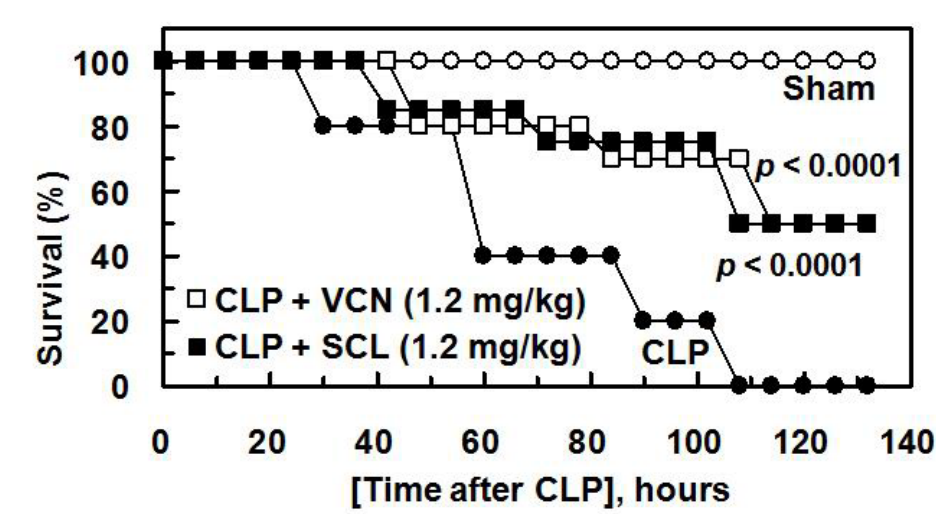
FIGURE 2 - Effects of VCN and SCL on CLP-induced septic lethality. Male C57BL/6 mice (n = 20) were administered VCN or SCL at 1.2 mg/kg (intravenous, i.v.) 12 h and 50 h after CLP. Animal survival was monitored every 12 h for 132 h after CLP. Control CLP-operated mice () and sham-operated mice () were administered sterile saline (n = 20). Kaplan-Meier survival analysis was used to determine the overall survival rates versus treated CLP-operated